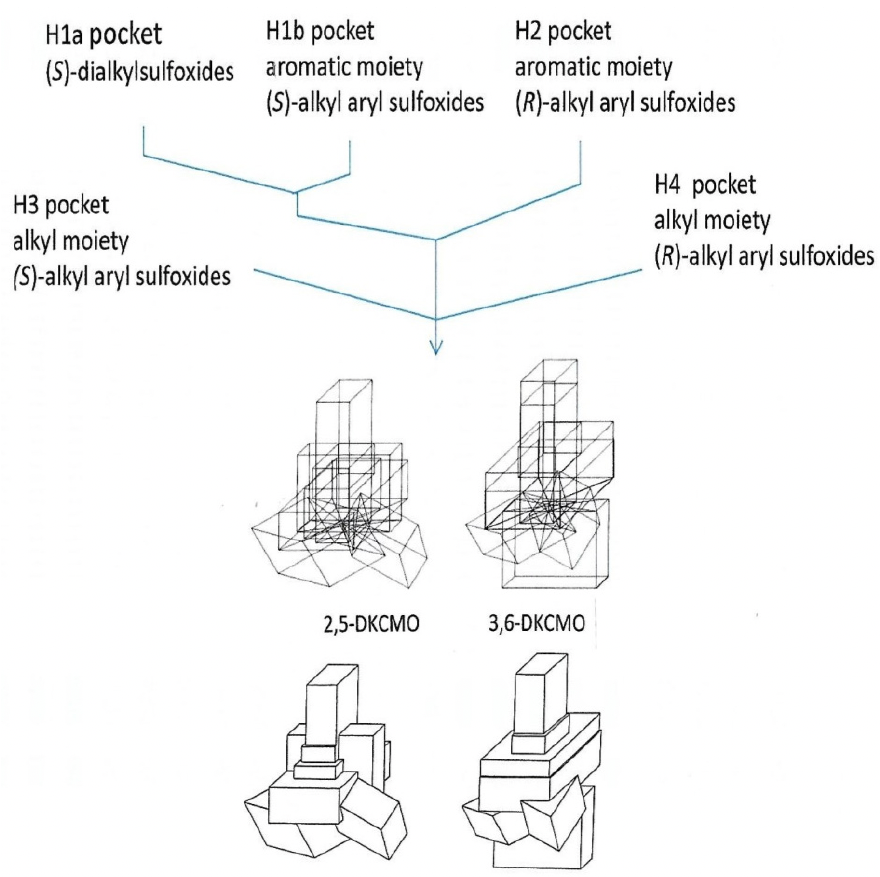
Figure 9. Rationale for superimposing the minimalised structures of the sulfoxides formed by 2,5-DKCMO and 3,6-DKCMO, and the resultant total dimensions (‘cubic space’) of the relevant enzyme active